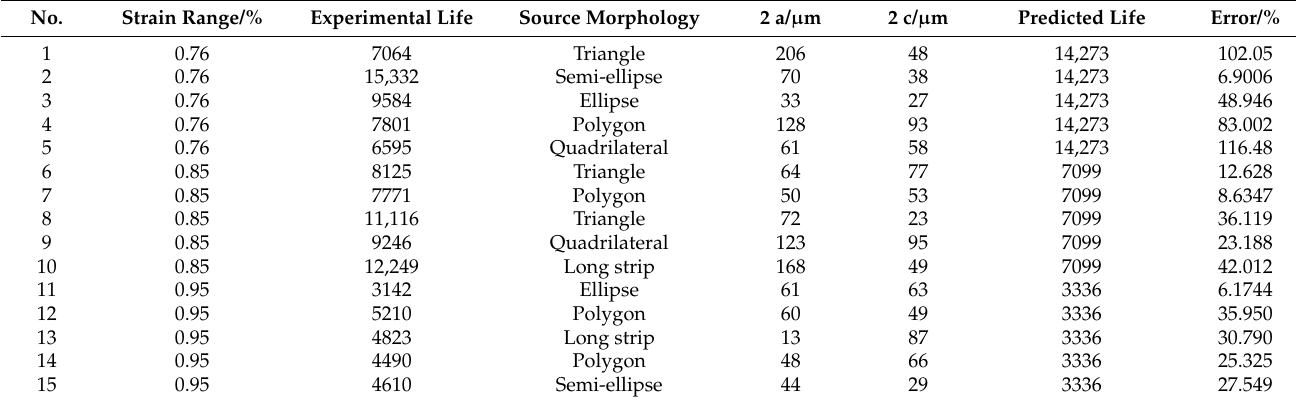
life. Table 5 lists these 15 selected experimental data and predicted life where specimens take with strain ranges of 0.95%, 0.85% and 0.76%, each in fact accounted for one-third respectively. The inclusion types and sizes are also listed in the table. By introducing the strain amplitude of the selected specimen into Equation (12), the predicted fatigue life of the specimen under this load condition can be calculated and assessed by error percentage Table 5. Fatigue life prediction results of selected fifteen to corresponding experimental life. Table 5. Fatigue life prediction results of selected fifteen specimens.